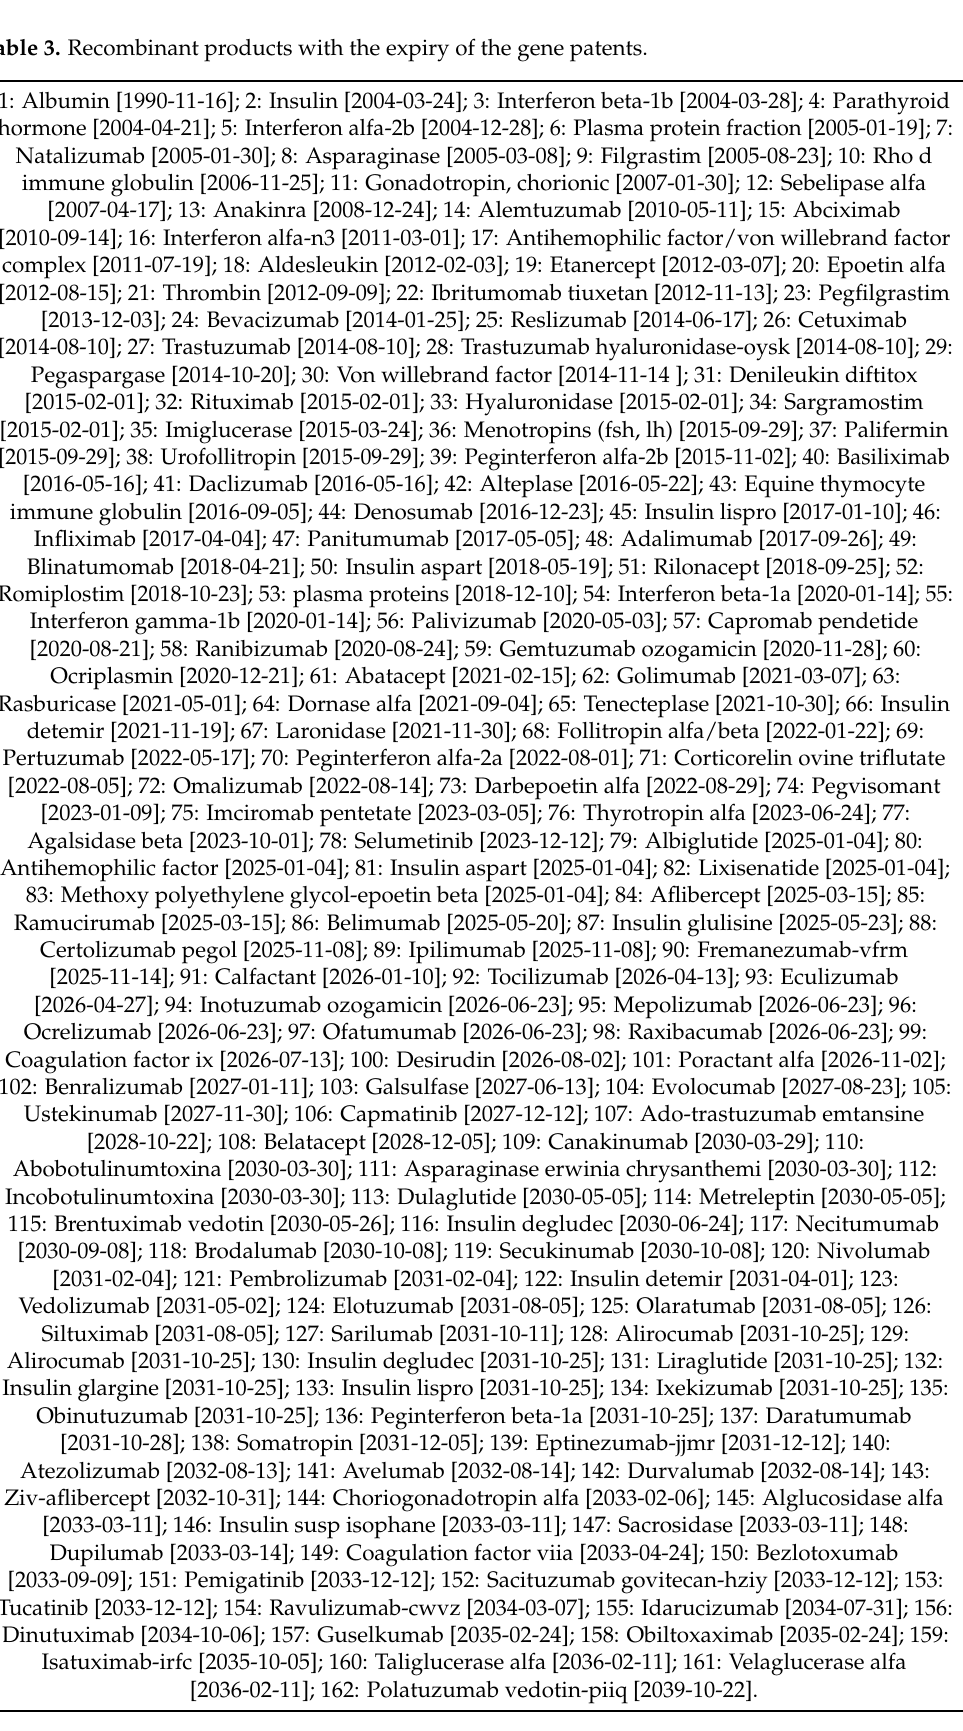
Table 3. Recombinant products with the expiry of the gene